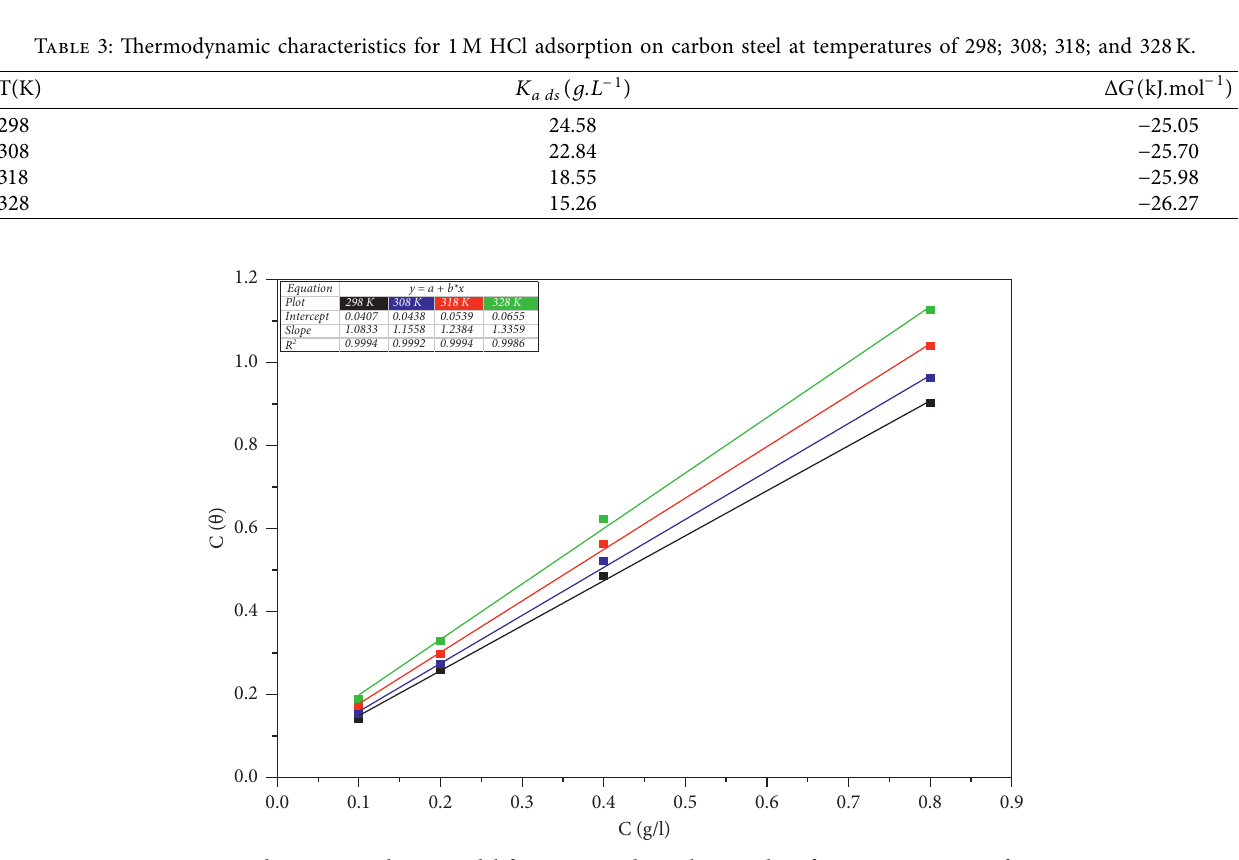
Figure 4: Langmuir adsorption isotherm model for EEW on the carbon steel surface at temperatures from 298 to